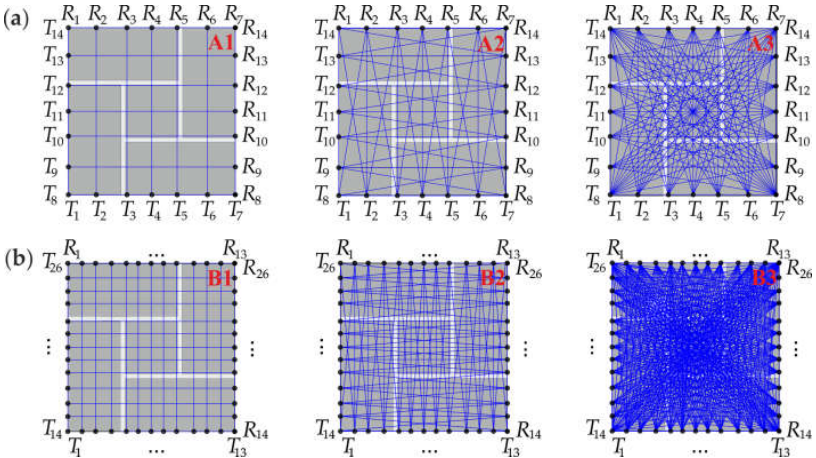
Figure 6. Configuration of paths: (a ) configuration #A (#A1, #A2 and#A3); ( b ) configuration #B (#B1, #B2 and#B3).